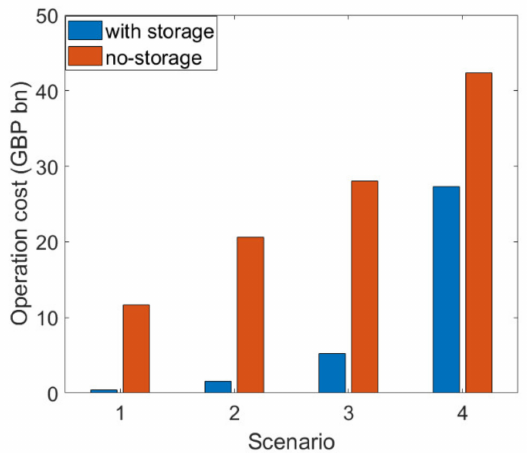
Figure 21. Optimal operation cost in the last epoch per scenario for the stochastic studies with and without storage.